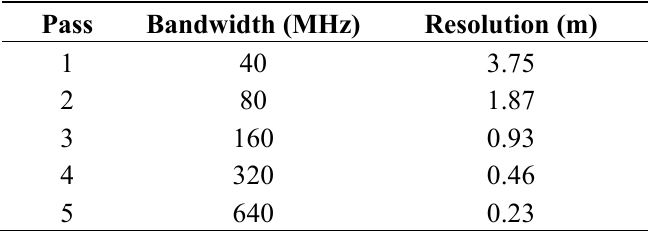
Table 2. Bandwidth and resolution for each pass of the multimodal